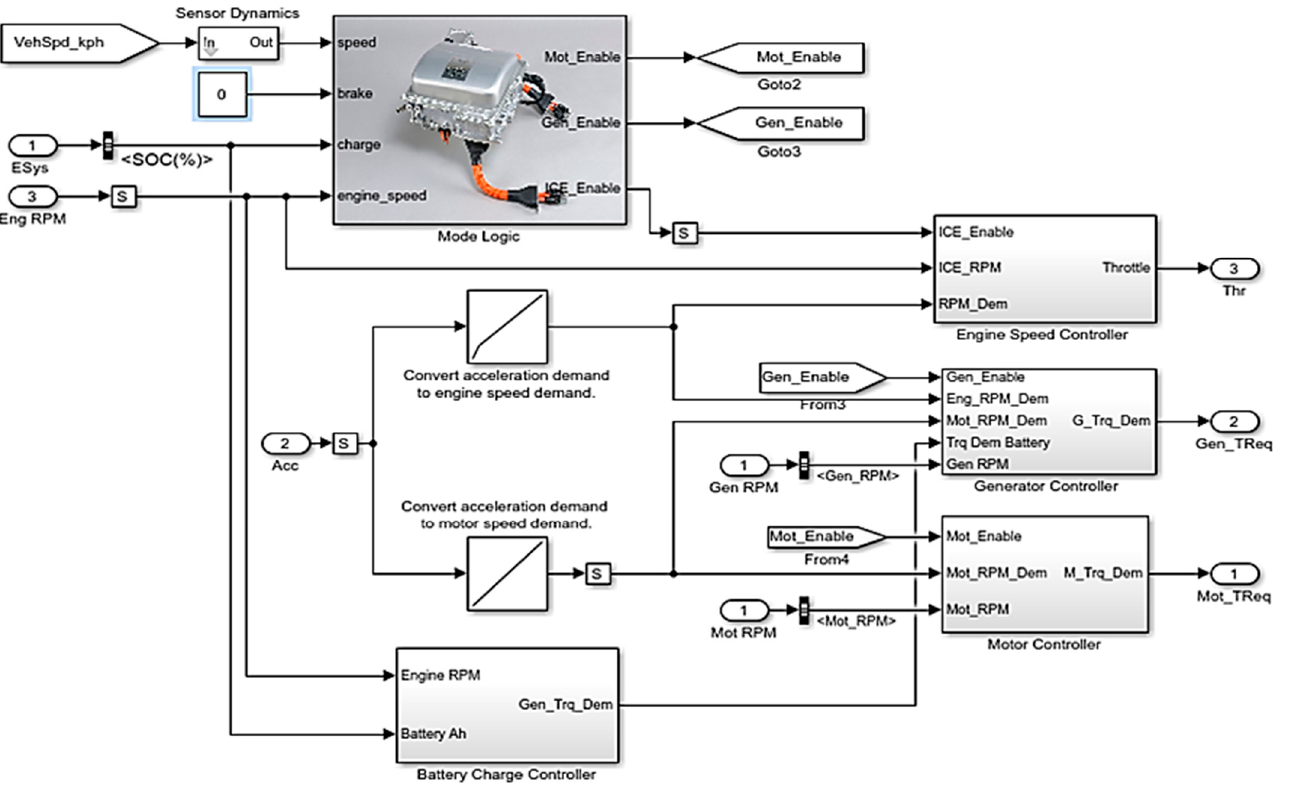
Figure 10. Modelling control system .